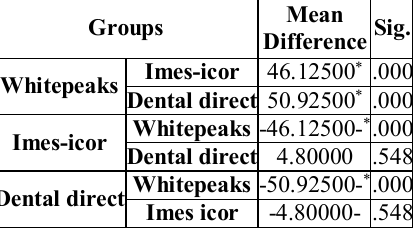
Table 3: LSD test between the three groups (Whitepeaks, Imes-icor and Dental direct)